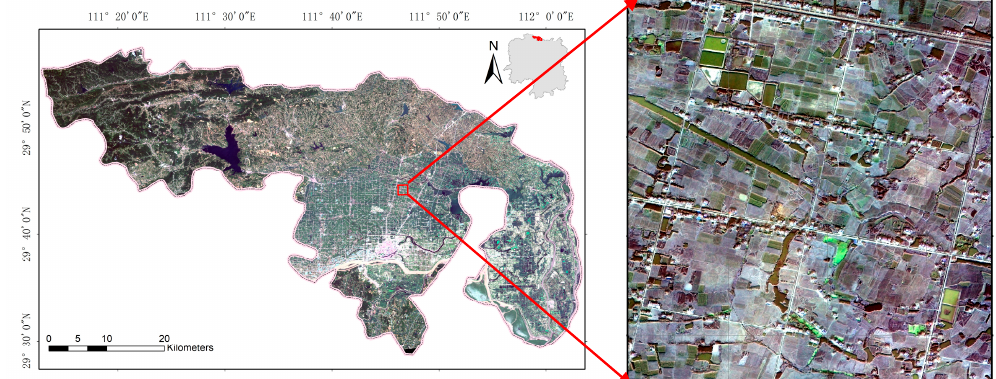
Figure 1. The location of the study area and an image of the sub-area, for detail.